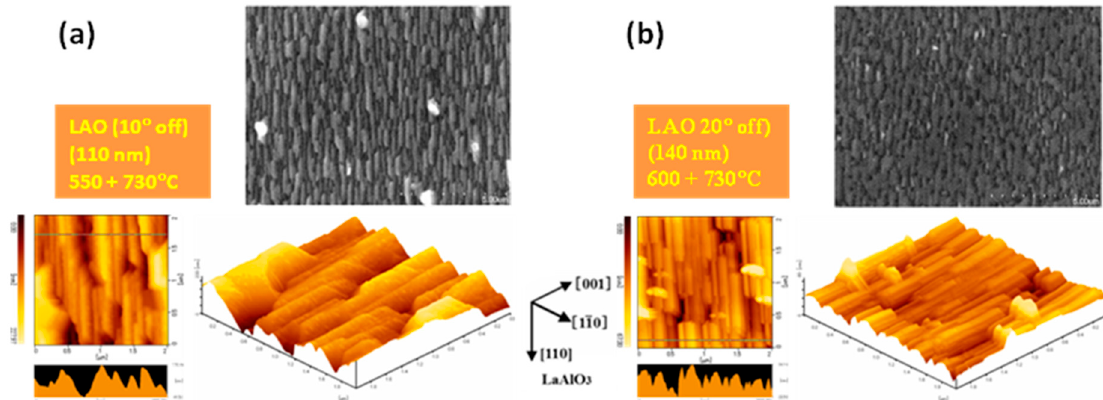
Figure 8. SEM and AFM images for non c -axis Bi-2212 thin films grown by the two-temperature method on vicinal (110) LAO substrates, ( a ) RMS = 38.46 nm, ( b ) RMS = 10.48 nm).